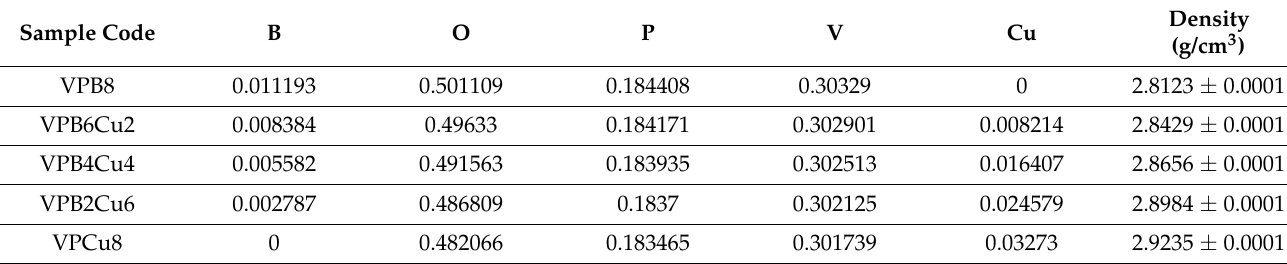
Table 1. Glass sample codes, composition, elemental weight fractions, and densities (wt.%).